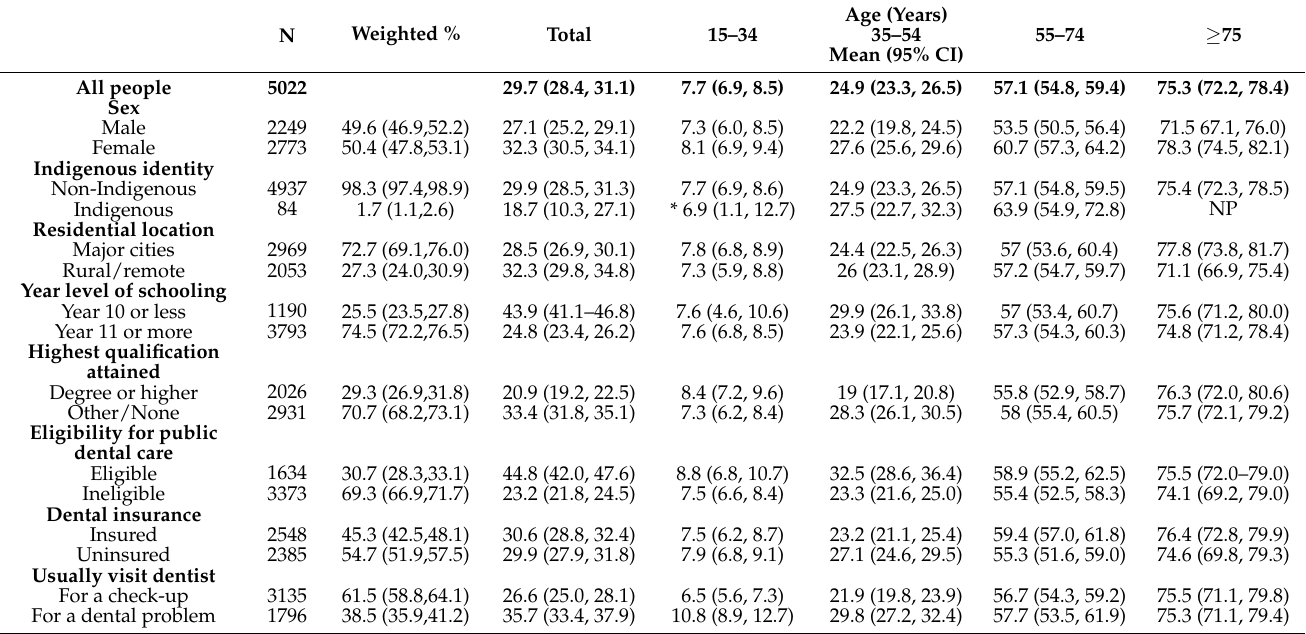
Table 3. Mean number of decayed, missing or filled tooth surfaces per person in Australian dentate adults aged 15 years and over.